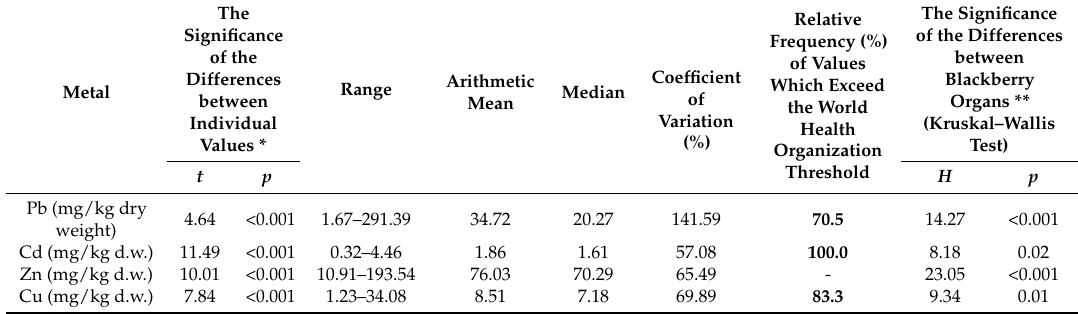
Table 7. Statistics of heavy metal content in the blackberry samples from Copsa Mic ă area,